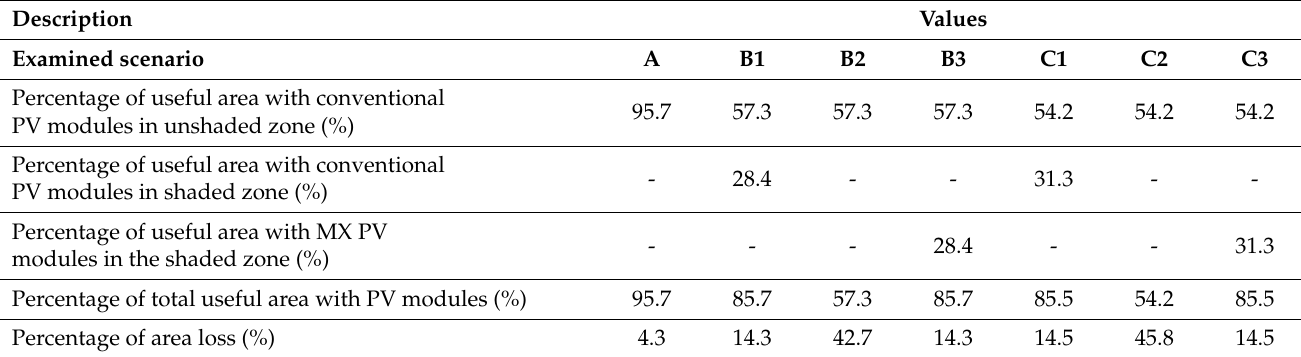
Figure 8. The unshaded and shaded zones, the 40 m 2 safety zones, and the compulsory distances belonging to each scenario of the examined area marked in different colors: ( A ) area of scenario A; ( B ) area of scenario B; ( C ) area of scenario C. Color codes: red, area loss due to area needs of fences, high-voltage transmission towers, their conductors and bases, and compulsory distance; gray, shaded zone; green, unshaded zone; yellow, 40 m 2 safety zones for electrical substations and inverters, based on [54,55]. Table 5. The proportions of the useful area of the model site by examined scenario according to the given mounting solutions of the conventional and MX PV modules.